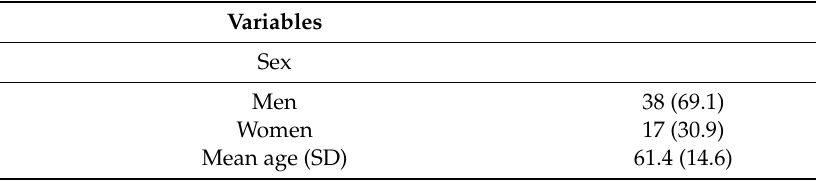
Table 1. Characteristics of the